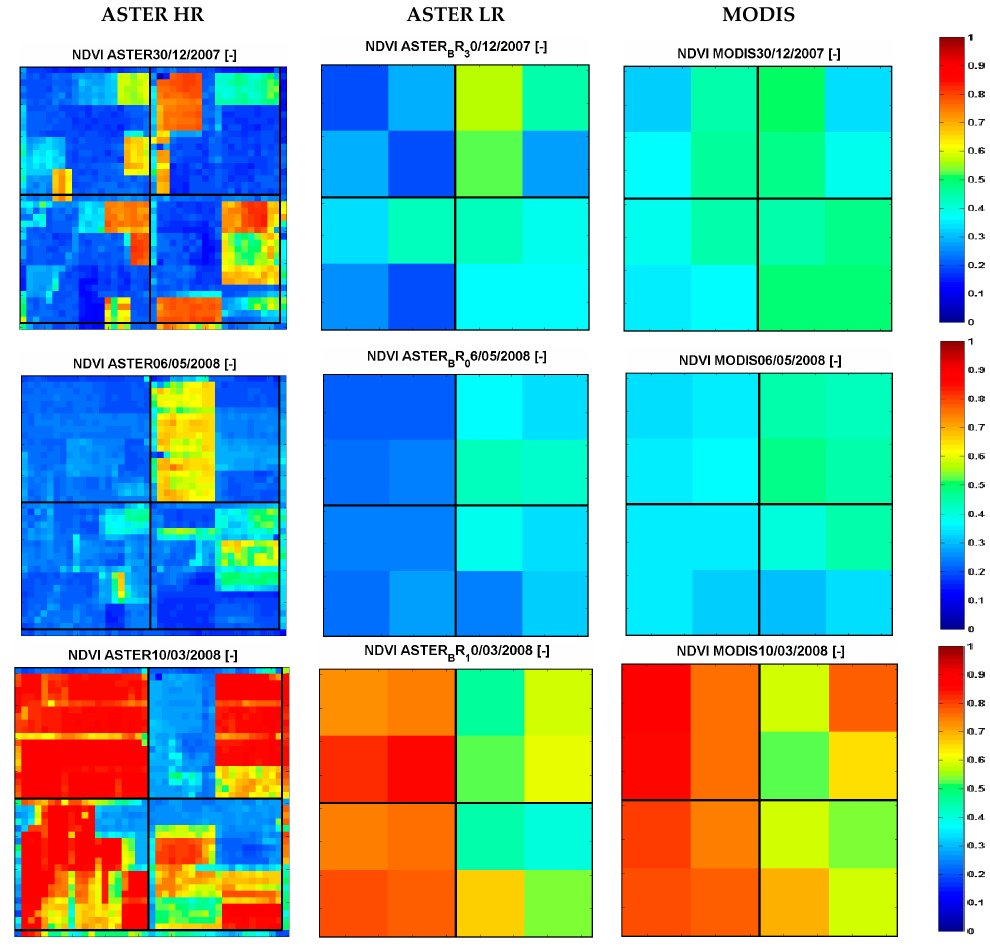
Figure 9. Discrepancies between LR and HR NDVI for three dates within the growing season.